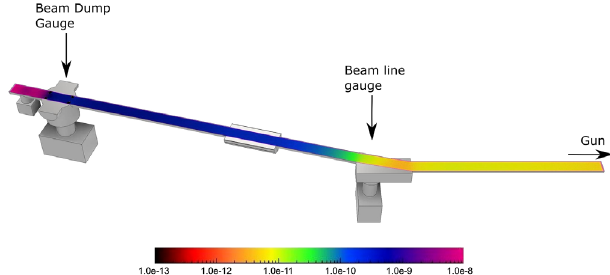
FIG. 12. M ol F low+ simulation of the beam line, assuming a 1 × 10 − 9 Torr vacuum in the beamstop.